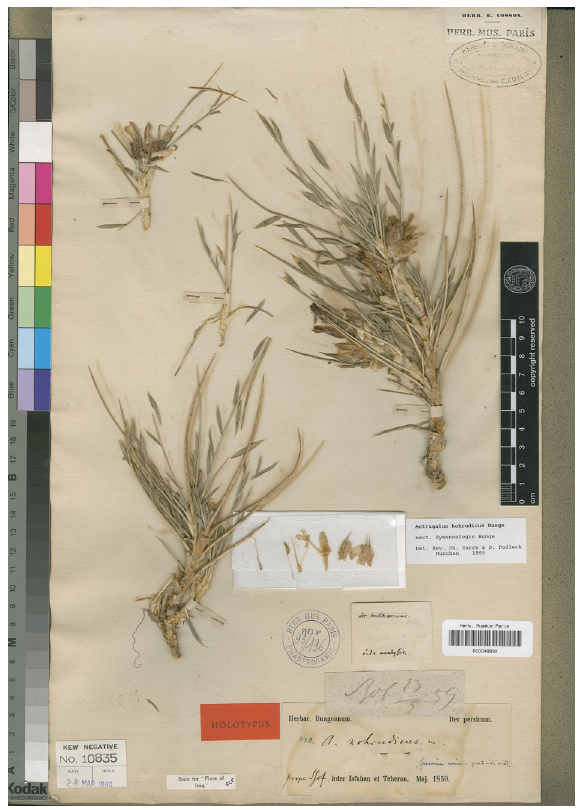
Fig 3. Holotype of Astragalus kohrudicus (digital barcode in P herbarium: P00048932).